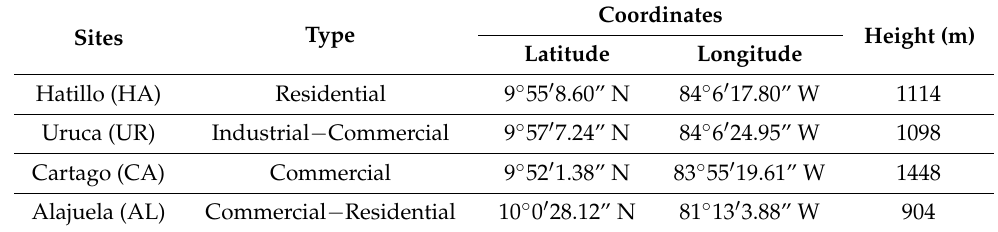
Table 1. PM 10 sampling sites in the metropolitan area of Costa Rica.